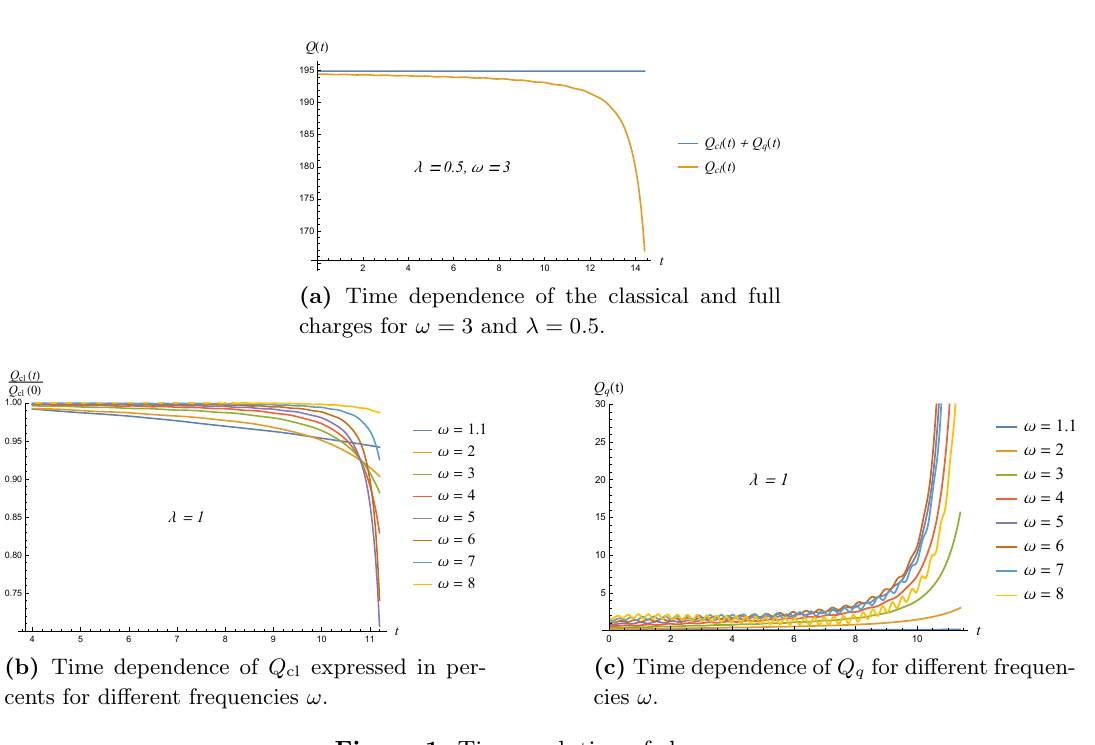
Figure 1 . Time evolution of charges.